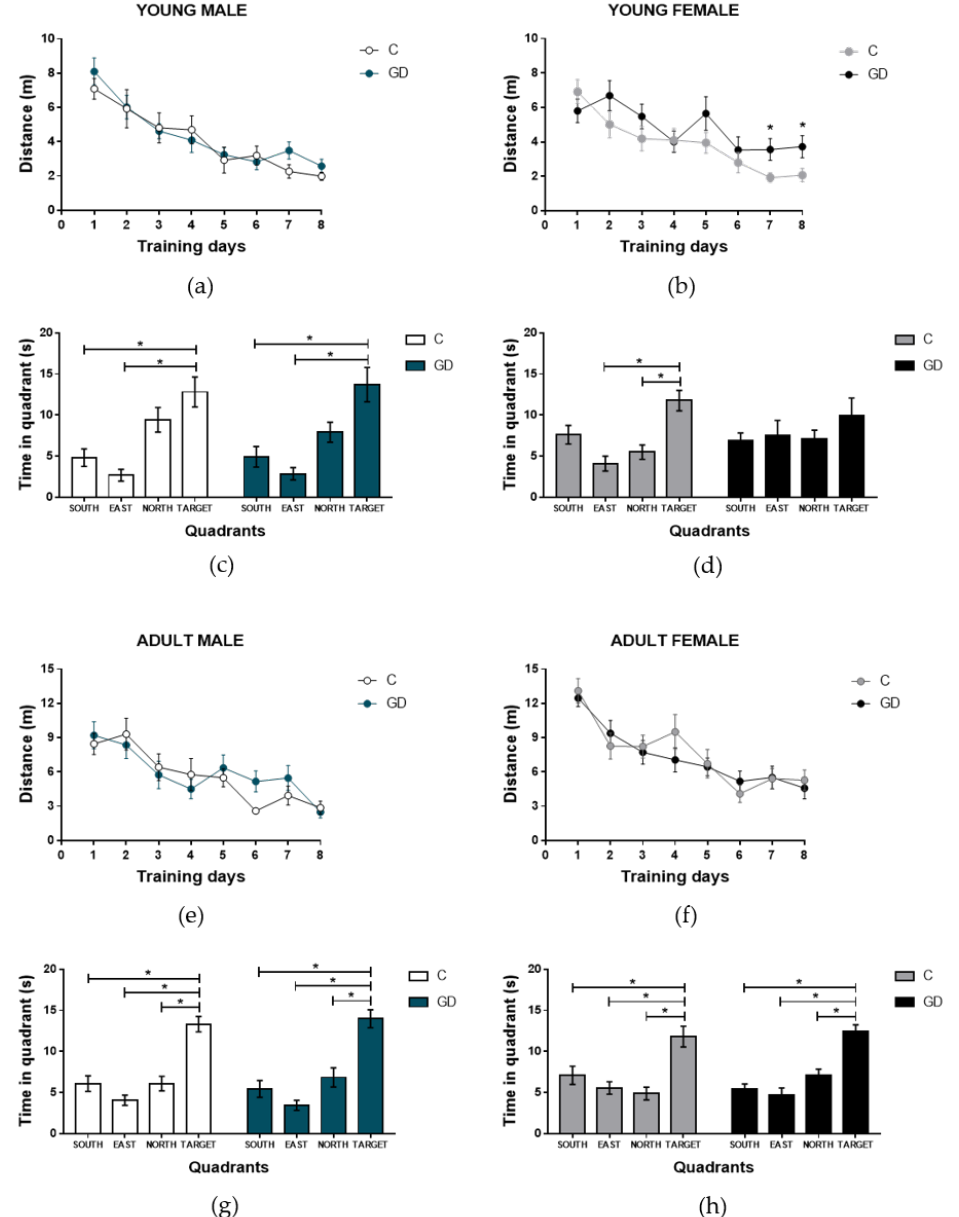
Figure 2. Effect of GD on the spatial learning of offspring, showing the distance traveled (m) during the training days and the probe trial and the time spent at each quadrant. The young male and female offspring distance ( a, b ) and time in each quadrant of young male and female offspring (c, d ) . The adult male and female offspring distance ( e, f ) and time in each quadrant of adult male and female offspring ( g, h ). C, control offspring; GD, gestational diabetes offspring. Control male offspring: young n = 10; adult n = 12, GD male offspring: young n = 10; adult n =12. Control female offspring: young, n = 10; adult, n = 10; GD female offspring: young: n = 10; adult, n = 10. Data are expressed as the mean ± SEM. Two-way ANOVA of repeated measures and one- way ANOVA; post hoc Tukey’s test; * p < 0.05.